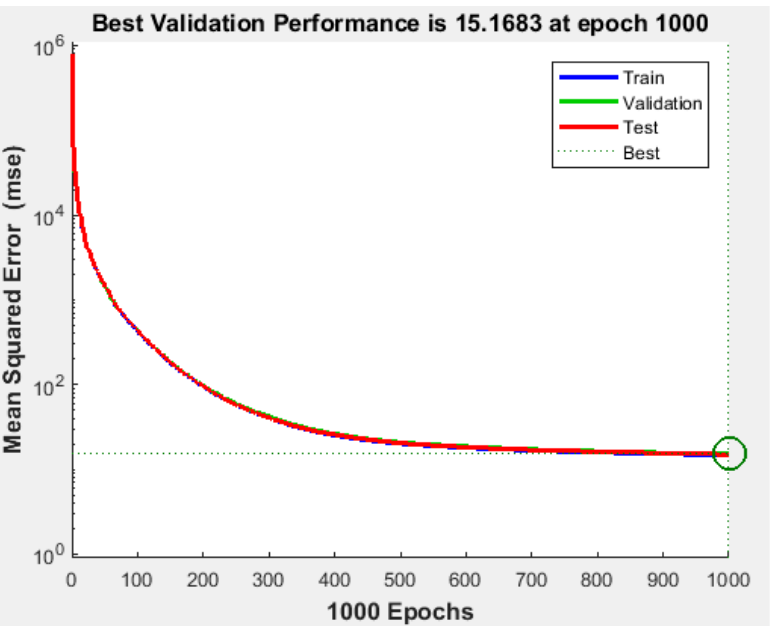
Figure 9. Performance of the training, validation, and testing data with the SCG learning algorithm at 1000 neurons in the hidden layer.